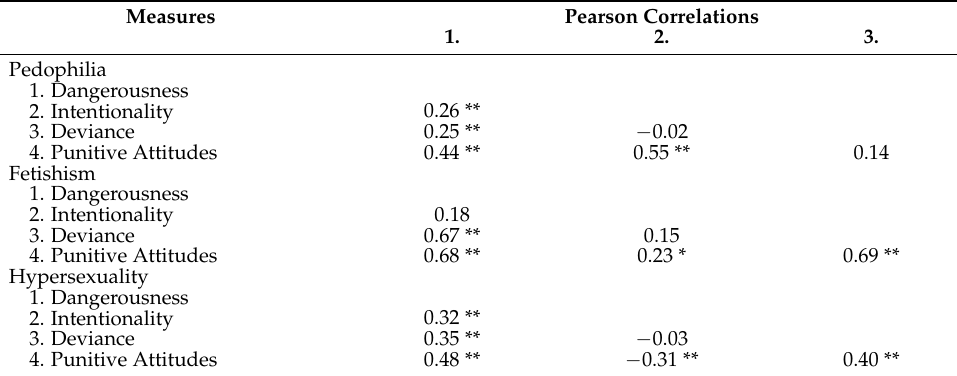
Table 1. Summary of Intercorrelations for Scores on Stigma and Punitiveness Measures for Pedophilia, Fetishism, and